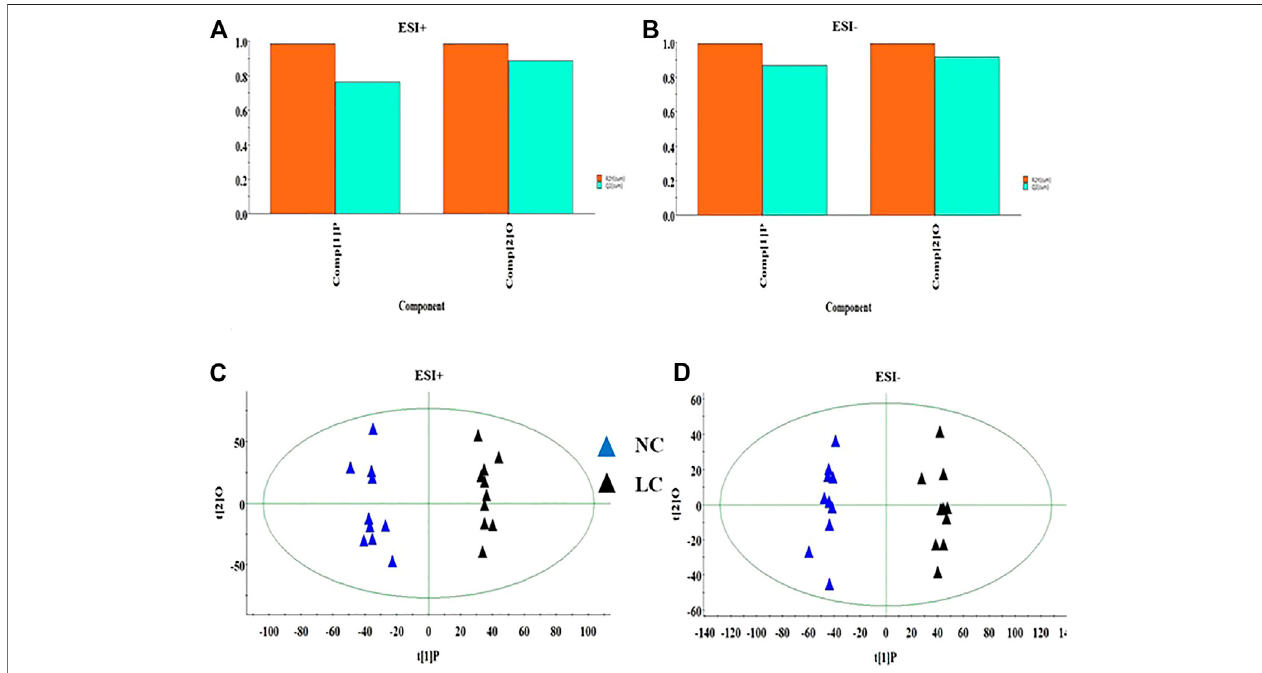
FIGURE4| ThegoodnessoffittestforOPLSmodelinESI+andESI-mode (A,B) .OPLS-DAanalysisofthedataderivedfromtheESI+andESI-modebetweenNC and LC group (C,D) .